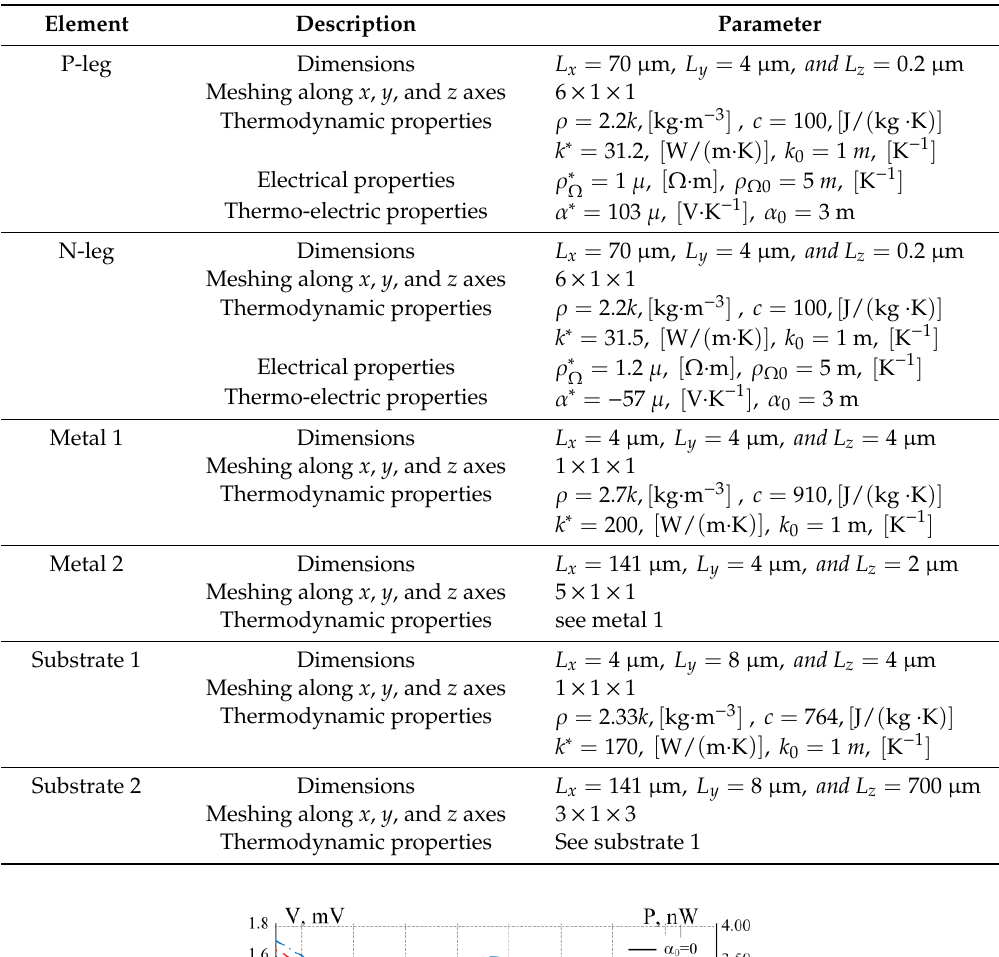
Table 3. Properties of the materials used in the thermoelectric couple under simulation.